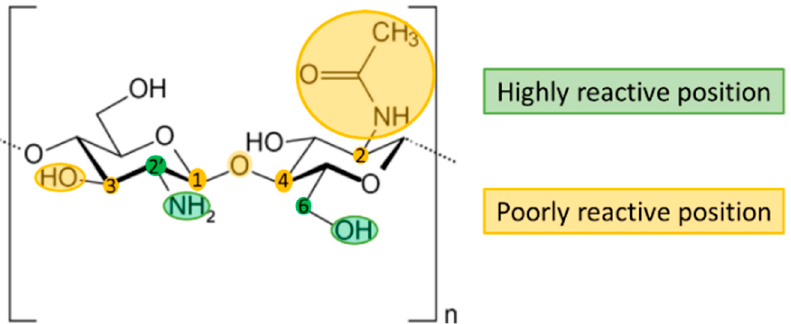
Figure 1. Chemical structure of chitosan. Highly reactive positions are highlighted in green, poorly reactive position are highlighted in yellow.